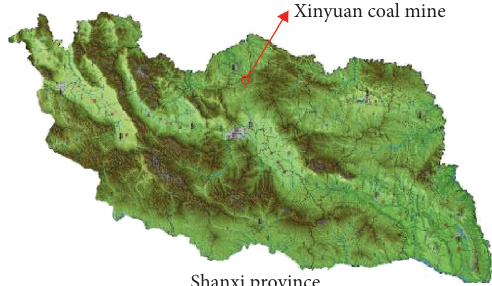
Figure 1: Location of Xinyuan coal mine.